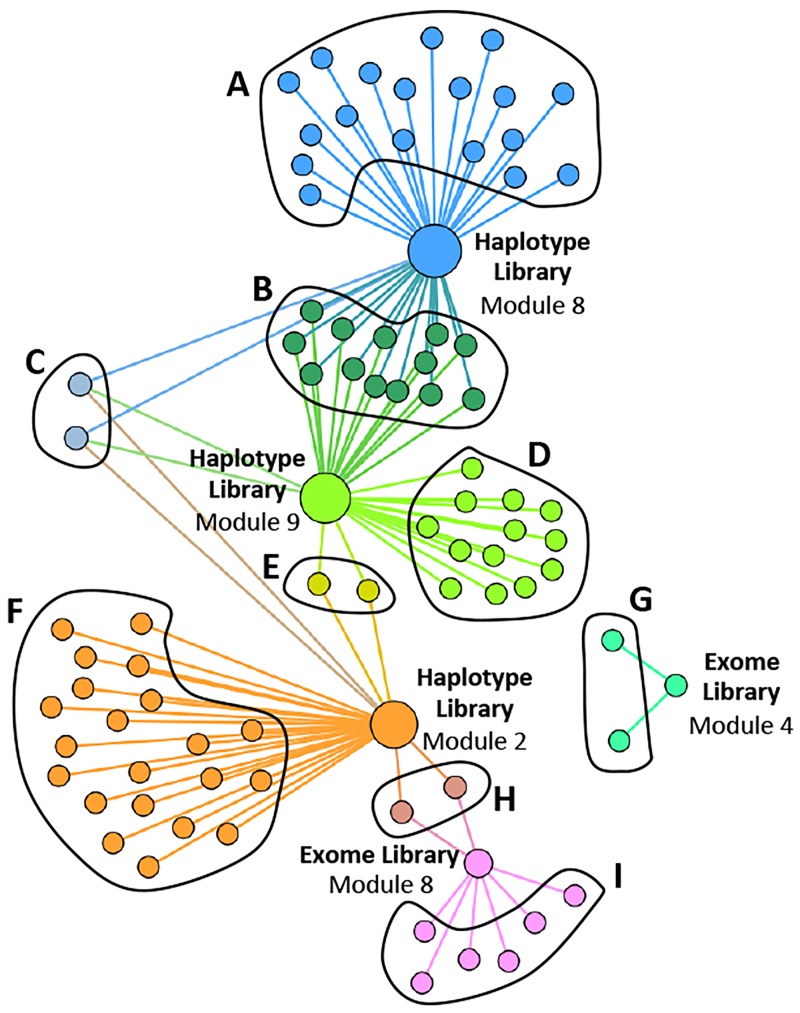
Ontology groups.Diagram showing the clusters of terms from the Gene Ontology analysis for biological processes related to preterm birth. Gene Ontology Database terms for biological processes shown in clusters A thru I are detailed in S3 Table.